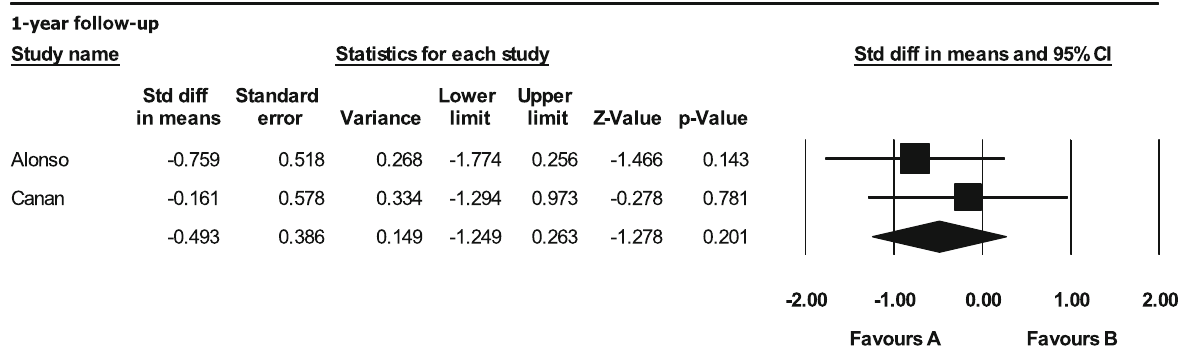
Fig. 4 Subgroup analysis of radiographic assessment between autologous bone and rh-BMP2 graft: bone graft volume after a 1-year